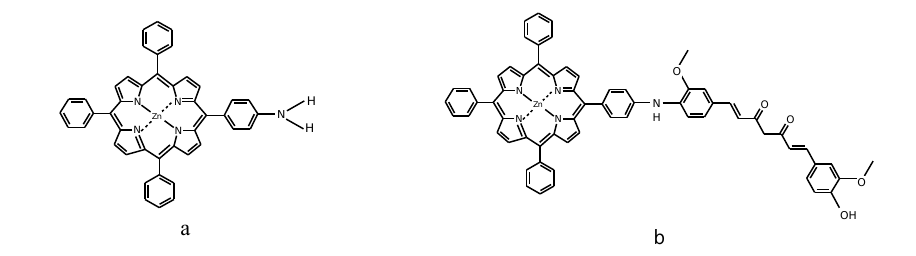
Fig. 1. Chemical structures of ZnATPP (a) and ZnATPP-СURC (b) compounds.